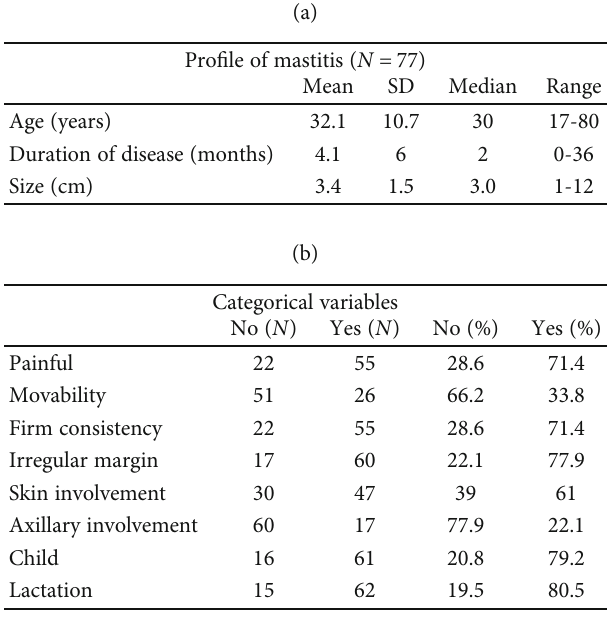
Table 3: Context variables for mastitis.